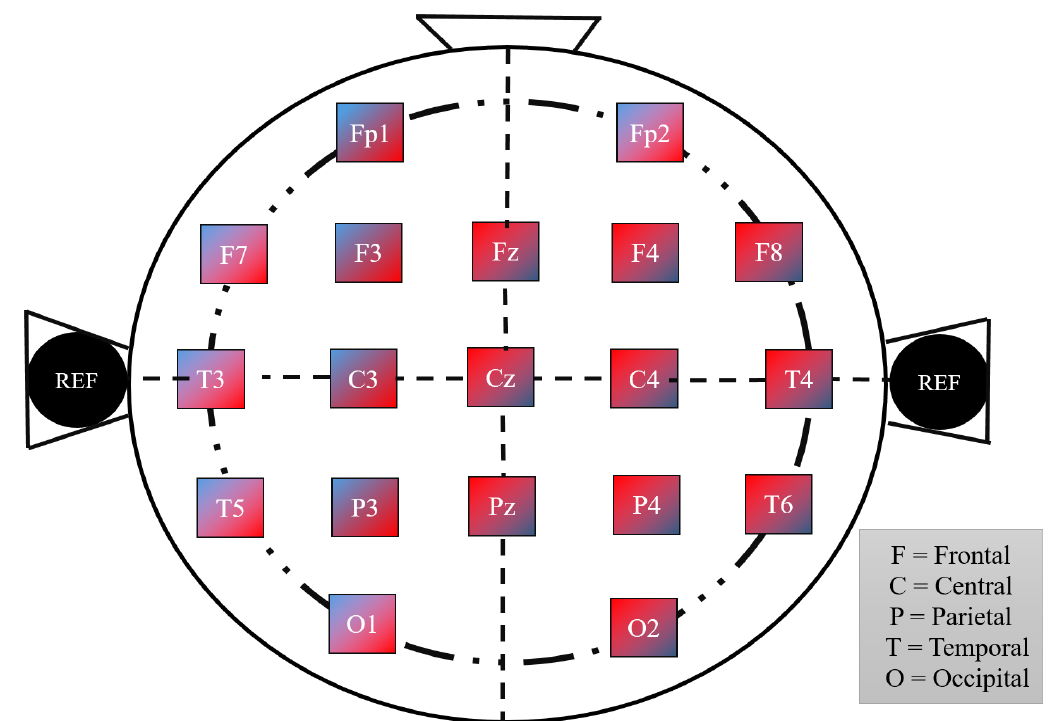
Figure 1. Electrode setup to record multi-channel EEG data for mental arithmetic tasks. The multi-channel EEG recordings were divided into two groups—good (G) and bad (B)—based on the arithmetic calculations performed by each subject. The GMAC class is interpreted as the subjects who performed good quality arithmetic calculations with the number of calculations per four minutes as 21 ± 7.4. Similarly, the BMAC is termed as the subjects who performed bad quality mental arithmetic calculations with the number of calculations per four minutes as 7 ±